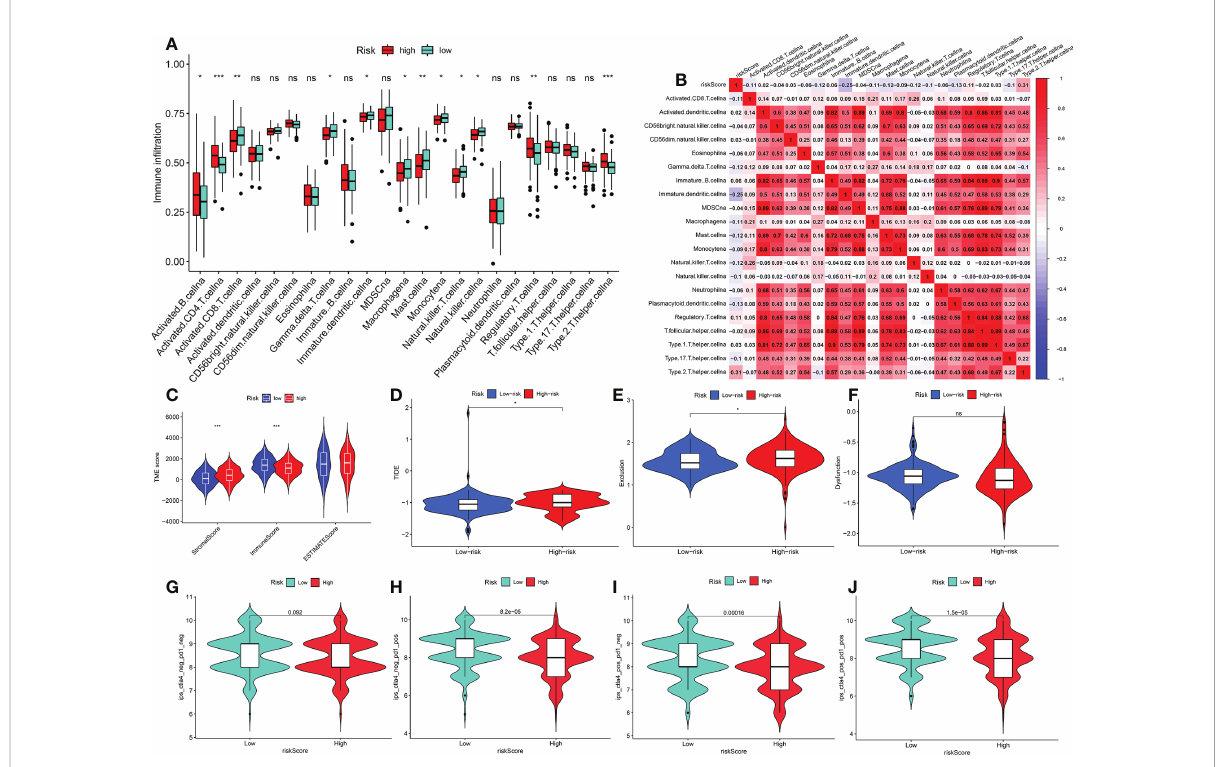
FIGURE 7 Characteristics of TME cell in fi ltration and immunotherapy analysis between two FRGPI subgroups (A) Immune landscape of 23 immune cells between risk hi and risk lo KIRP groups. * p < 0.05; ** p < 0.01; *** p < 0.001; n.s., not signi fi cant. (B) Correlation analysis between 23 immune cells and risk score (FRGPI score). (C) The distributions of tumour tissue scores in riskhi and risklo groups (D – F) Comparisons of TIDE, MSI, T cell rejection and T cell dysfunction score between different FRGPI subgroups. (G – J) Differential analysis of response to anti-PD-L1 and CTLA-4 immunotherapy in riskhi and risklo groups. p < 0.05 is considered to be signi fi